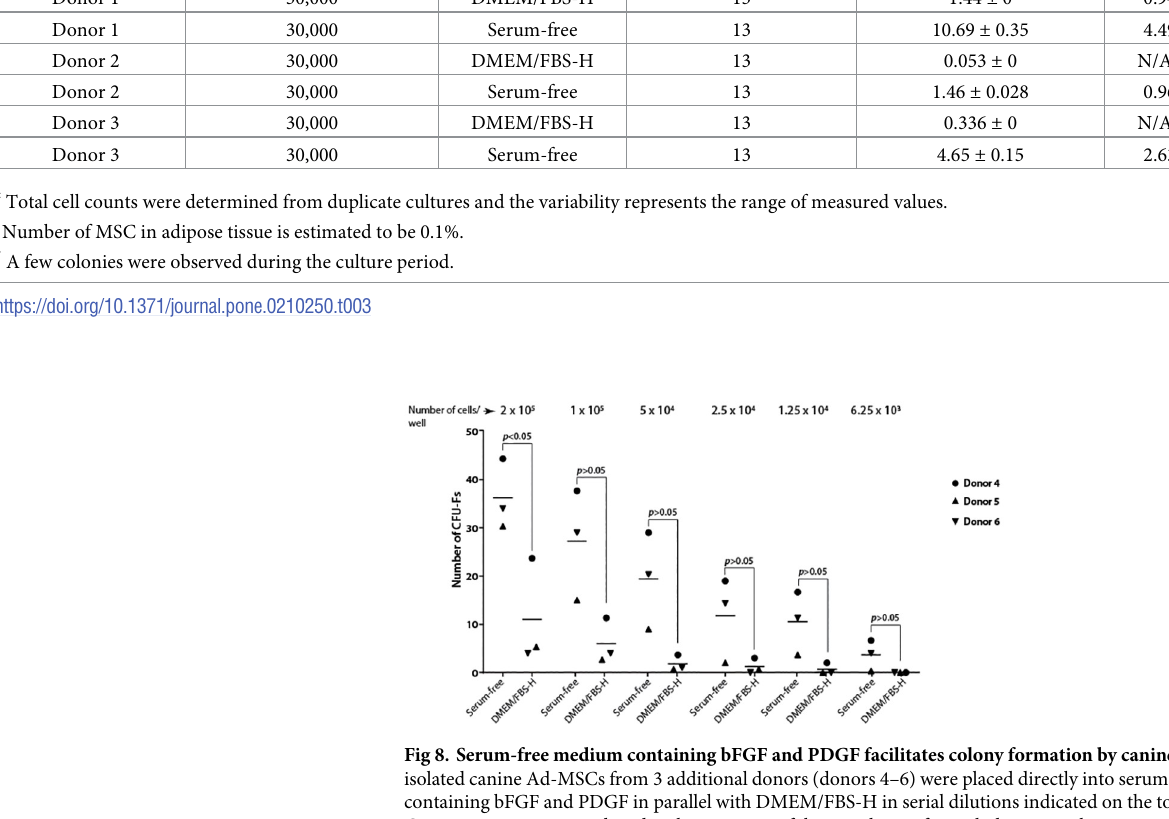
Table 3. Cell yields comparison of canine Ad-MSC cultured in DMEM/FBS-H or serum-free medium containing bFGF and PDGF. Animal number